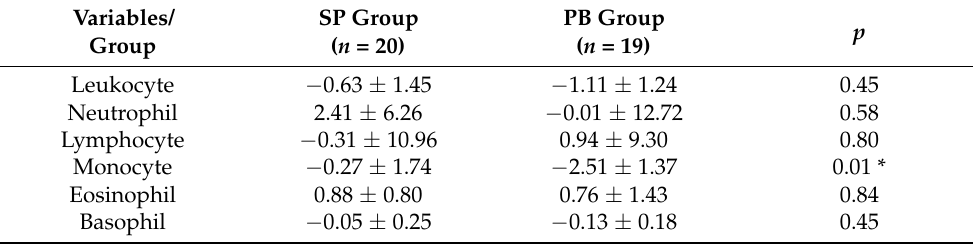
Table 5. A comparison of immune cells ratios within